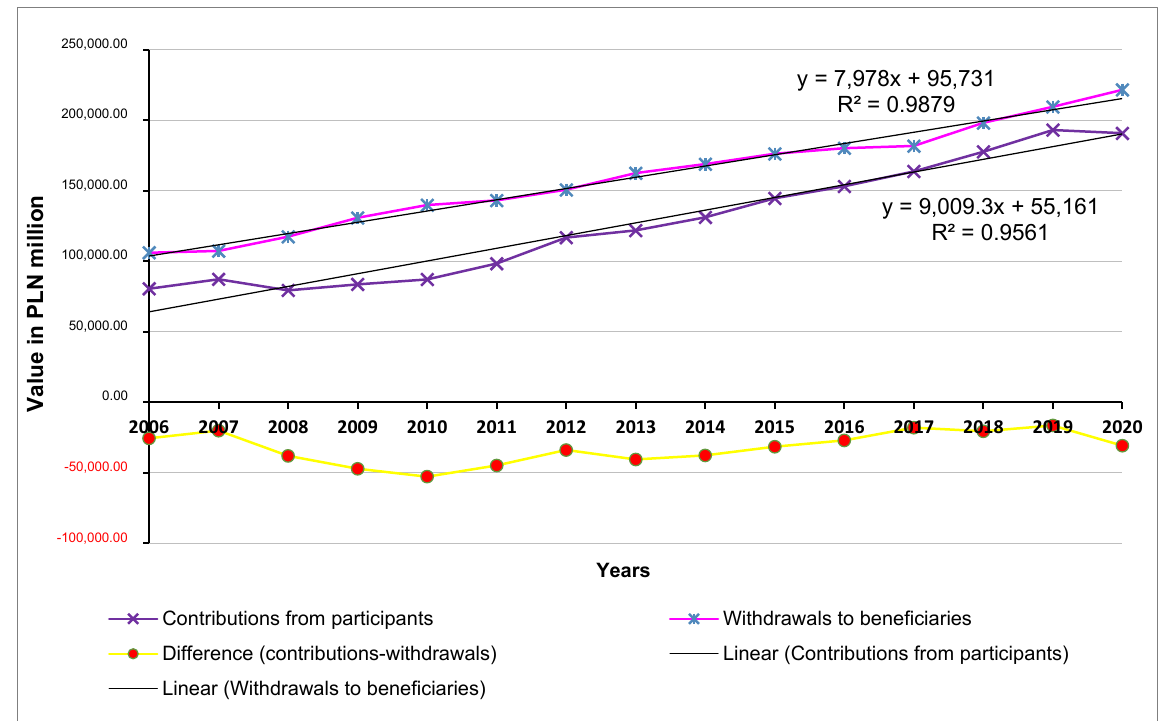
Figure 3. Contributions to and withdrawals from the Pension Fund (2006–2020). Source: Own calculations based on data from the Social Insurance Institution.